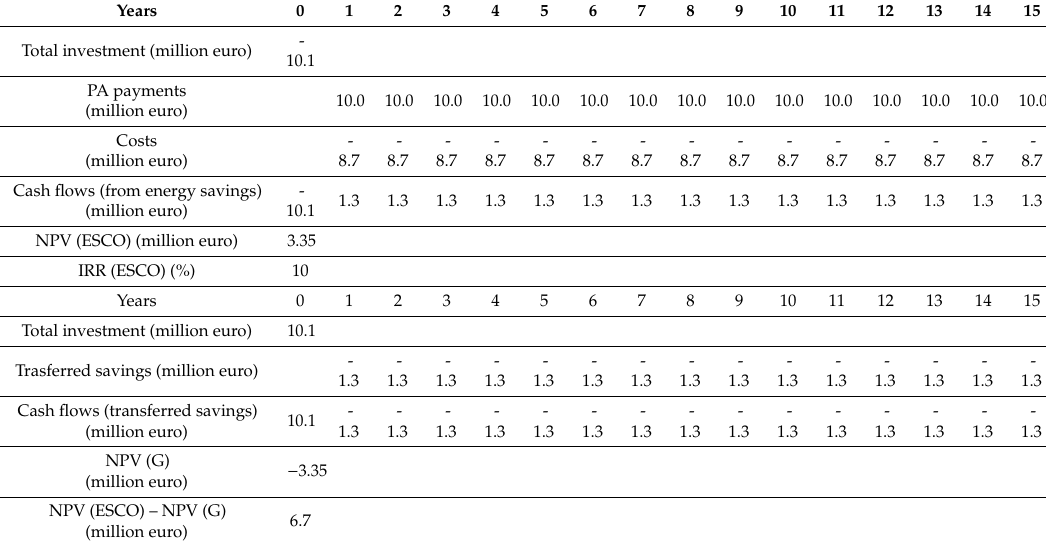
Table A1. First out contract—cash flows.